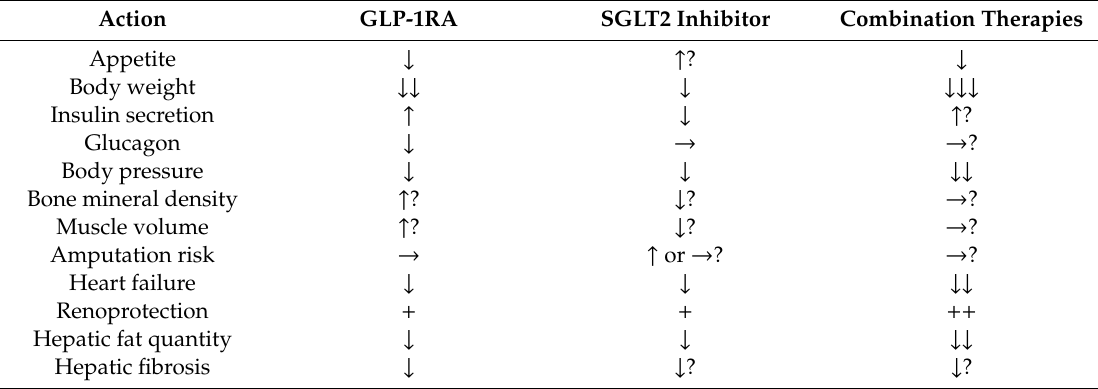
Table 3. The potential benefit of the combination of GLP-1RA / SGLT2 inhibitor therapy [88–91].